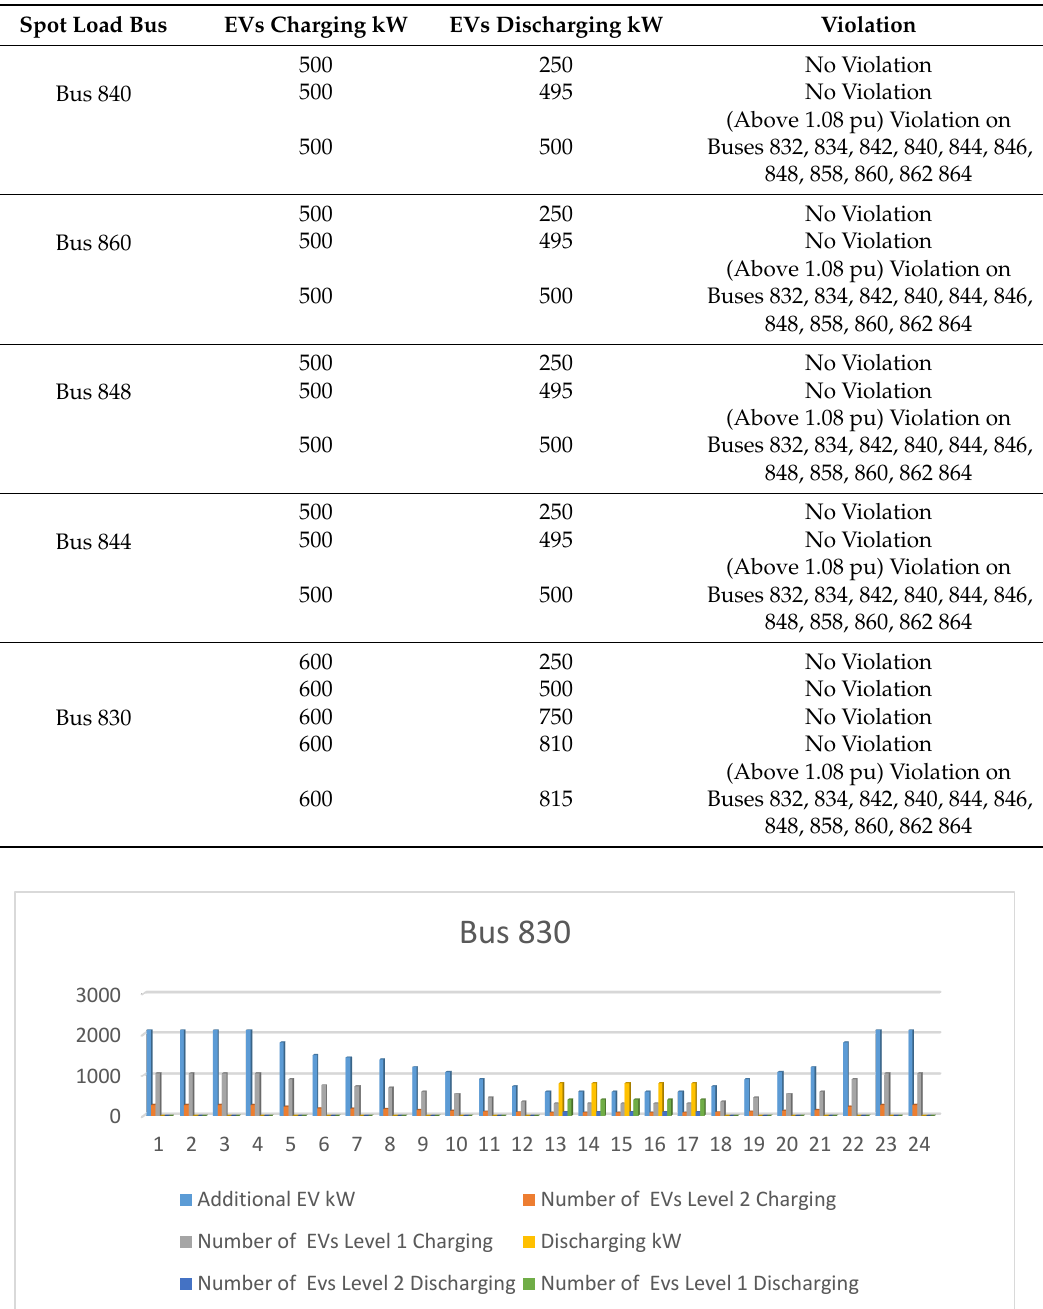
Table 7 . Case 3 Maximum Charging/Discharging Load kW during Peak Hours.